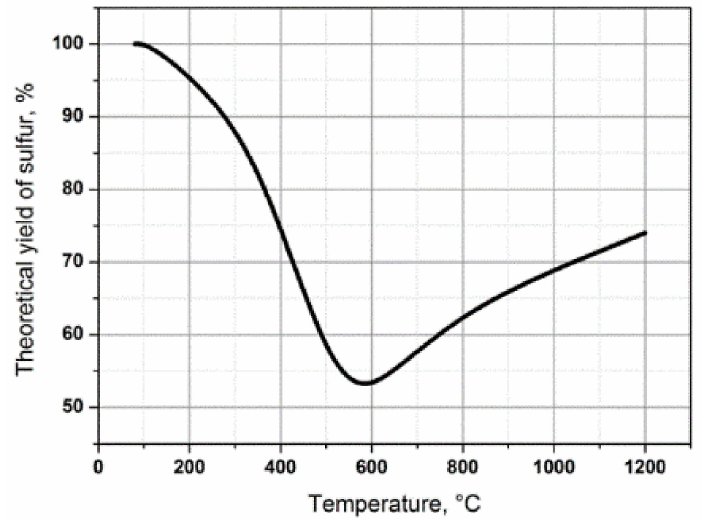
Figure 5. The dependence of the equilibrium sulfur yield on the temperature in the reaction of direct oxidation of hydrogen sulfide at atmospheric pressure (adapted from